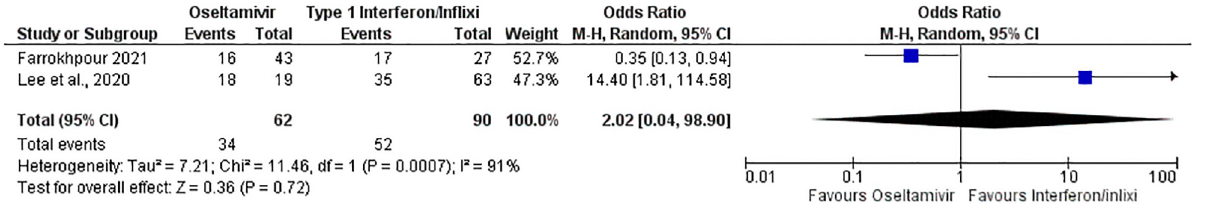
Fig 6. Forest plot. Shows the meta-analysis comparing the survival of the oseltamivir group to the type 1 Interferon/Infliximab groups.